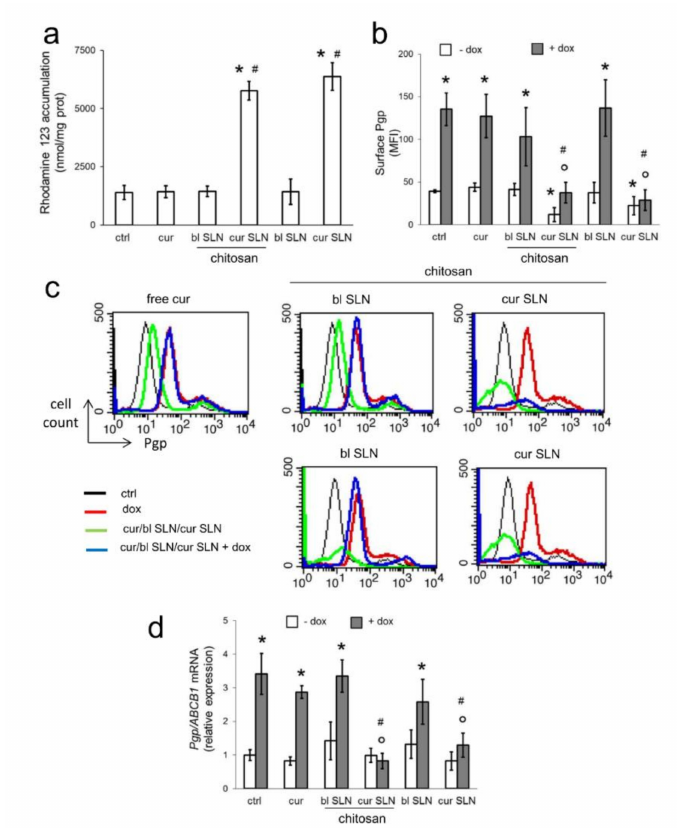
Figure 2. E ff ects of CURC-loaded SLNs on Pgp activity and expression. MDA-MB-231 cells were incubated for 24 h with fresh medium (ctrl), with 5 µ M CURC (cur), blank SLN (bl SLN), CURC-loaded SLN (cur SLN, containing 5 µ M cur), and with or without chitosan. When indicated, 5 µ M doxorubicin (dox) was added. ( a ) The Pgp substrate rhodamine 123 was added in the last 20 min. The intracellular accumulation of rhodamine 123 was measured fluorimetrically in duplicates. Data are presented as means ± SD ( n = 3). * p < 0.001: vs. ctrl; # p < 0.001 vs. cur. ( b ) Pgp on cell surface was measured by flow cytometry; results were expressed as mean fluorescence intensity (MFI). Measurements were performed in triplicate. Data are presented as means ± SD ( n = 3). * p < 0.01: vs. ctrl; ◦ p < 0.001: vs. dox; # p < 0.001 vs. cur. ( c ) Representative histograms of one out of three experiments. ( d ) The expression of the Pgp mRNA was measured by qRT-PCR in triplicates. Data are presented as means ± SD ( n = 3). * p < 0.01: vs. ctrl; ◦ p < 0.001: vs. dox; # p < 0.001 vs.